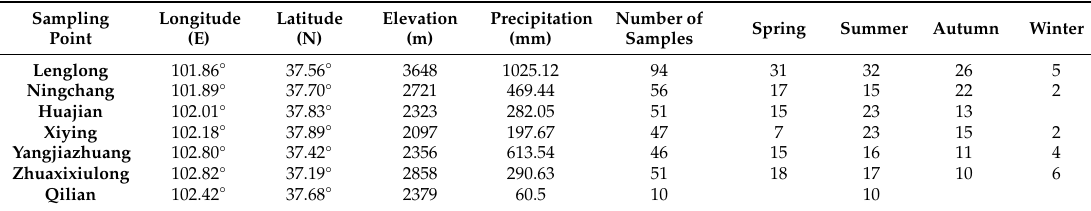
Table 1. Sampling location and sample